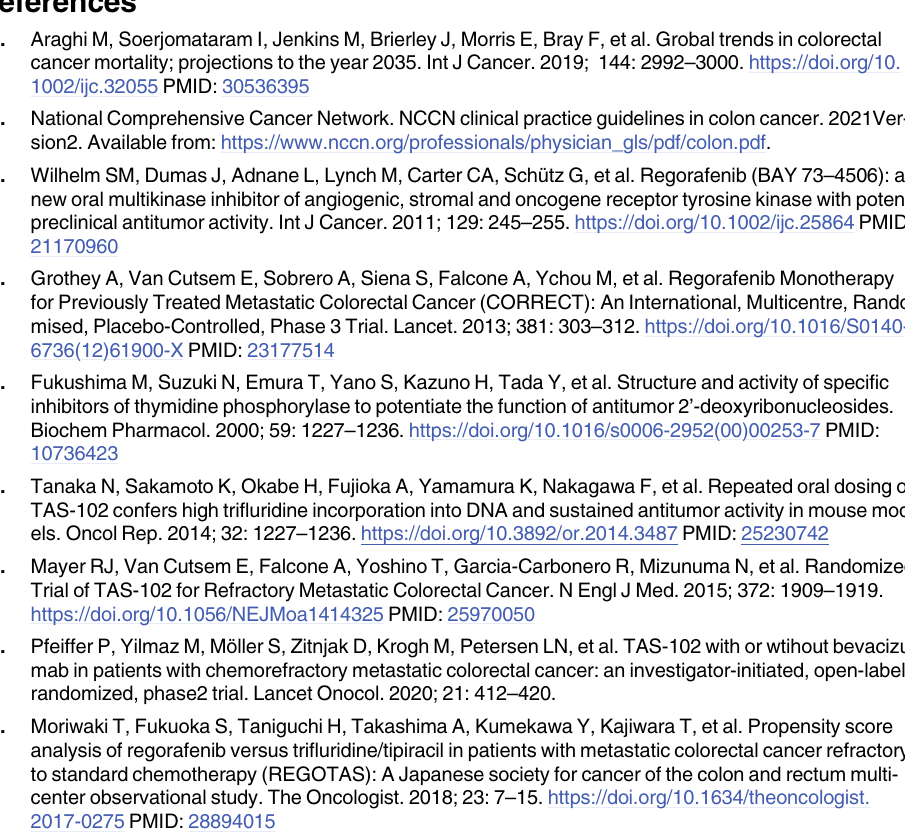
S2 Table. The differences in the T-PFS and OS among the three groups. S3 Table. The differences in the TGR and TGK among the drugs in the three